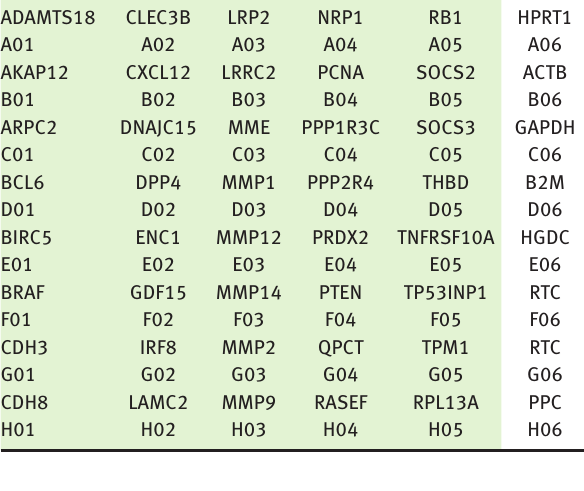
Table 3: Melanoma PCR Array 48 well microplate gene design.